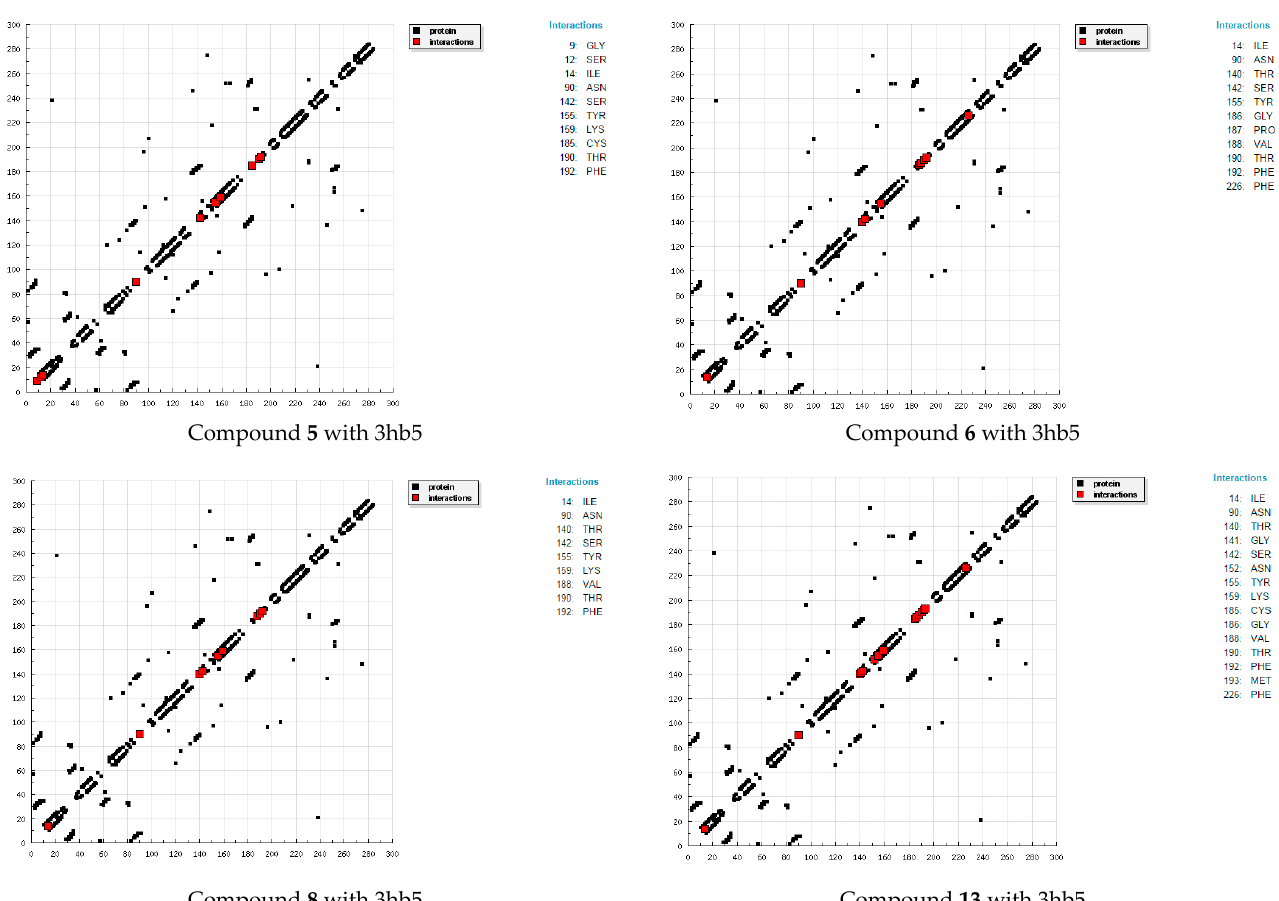
Figure 4. HB plots of interaction between some synthesized compounds and breast cancer (3hb5) hormone.